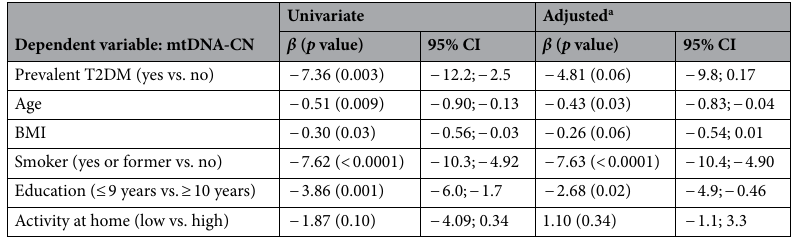
Table 3. Association between prevalent T2DM and mtDNA-CN using linear regression models. a Adjusted for all variables (prevalent T2DM, age, BMI, smoking, education and activity at home). Cancer at or before baseline were